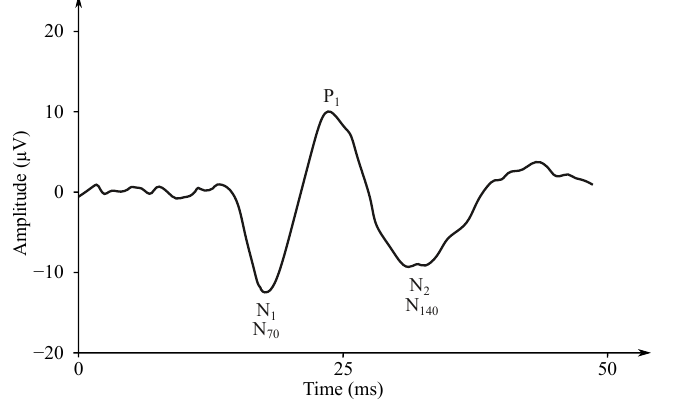
Figure 7. Example of AEP signal